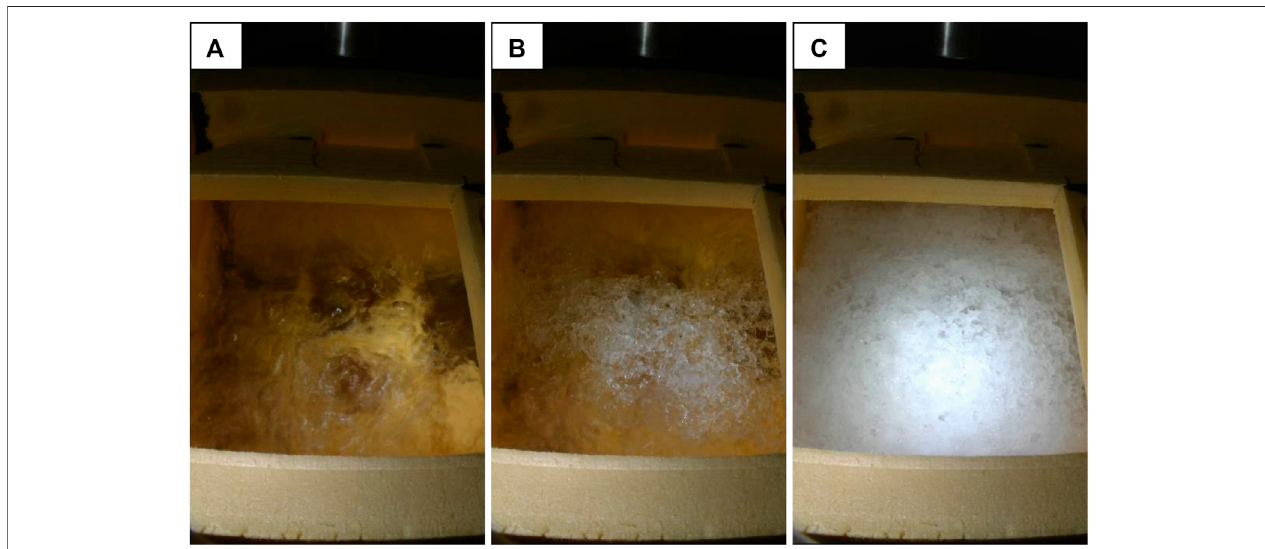
FIGURE7| Aggregatestatesofnitrogen insidethecryo-box. (A) Liquidnitrogenabove125 mbar; (B) Phasetransitionattriplepoint(125 mbar); (C) Solidnitrogen below 125 mbar.